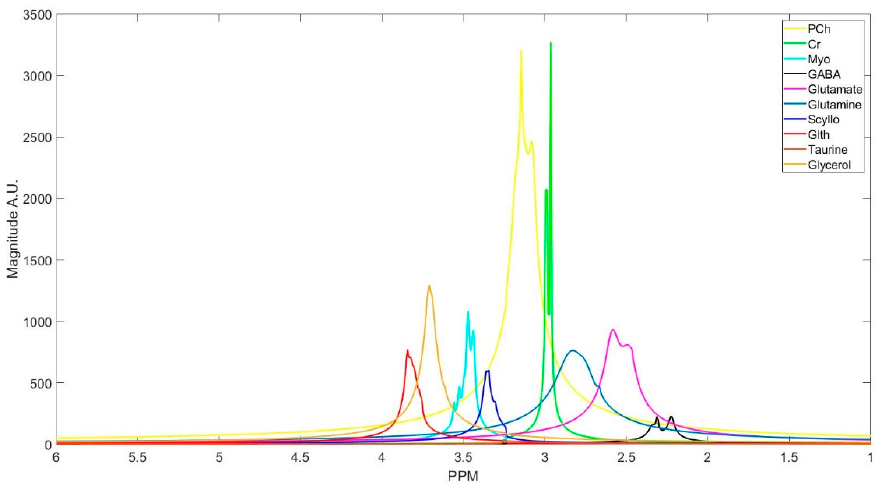
Figure A5. Clustered metabolites basis sets of group Figure 10. Clustered metabolites basis sets of group 2.